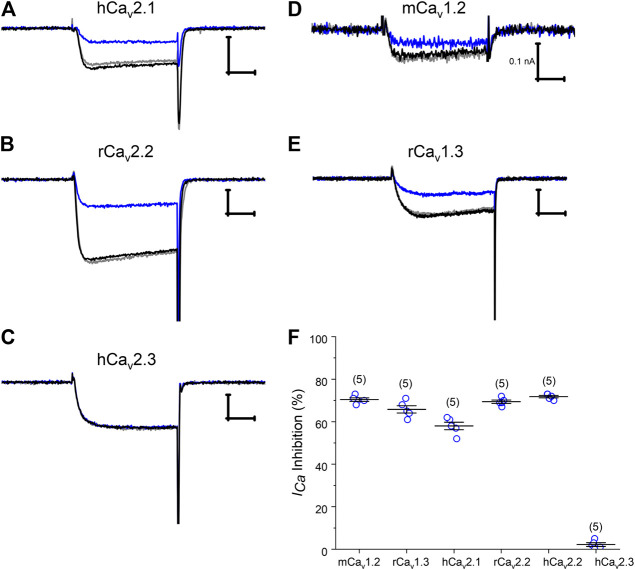
Pn3a modulation of recombinant HVA Cav channels. (A–E) Representative current traces of Cav2.1, Cav2.2, Cav2.3, Cav1.2, and Cav1.3 mediated Ca2+ currents in control (black), in the presence of 10 µM Pn3a (blue), and after washout (gray). (F) Summary bar graph comparing 10 µM Pn3a inhibition (%) of heterologously expressed HVA calcium channels predominantly expressed in rodent DRG neurons. Mouse Cav1.2, rat Cav1.3, 2.2 and human Cav2.1, 2.2, 2.3 channels were all co-expressed with human β3 and α2δ1 in HEK293 cells (n = 5 for each channel). X scale bar 5 msec; Y scale bar 0.5 nA, unless noted.